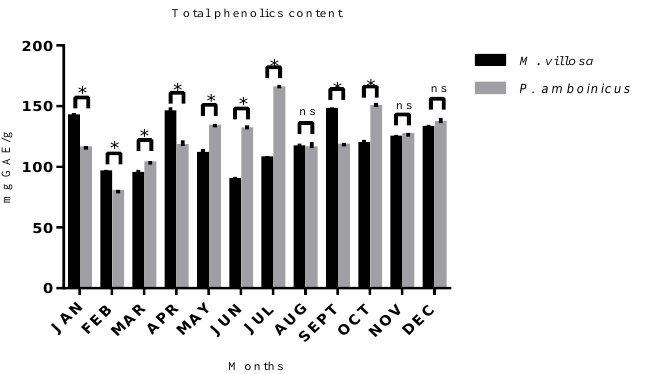
Figure 1. Polyphenols content of M. villosa and P. amboinicus throughout 12 months and their statistical differences. ns = nonsignificant. * statistical difference.